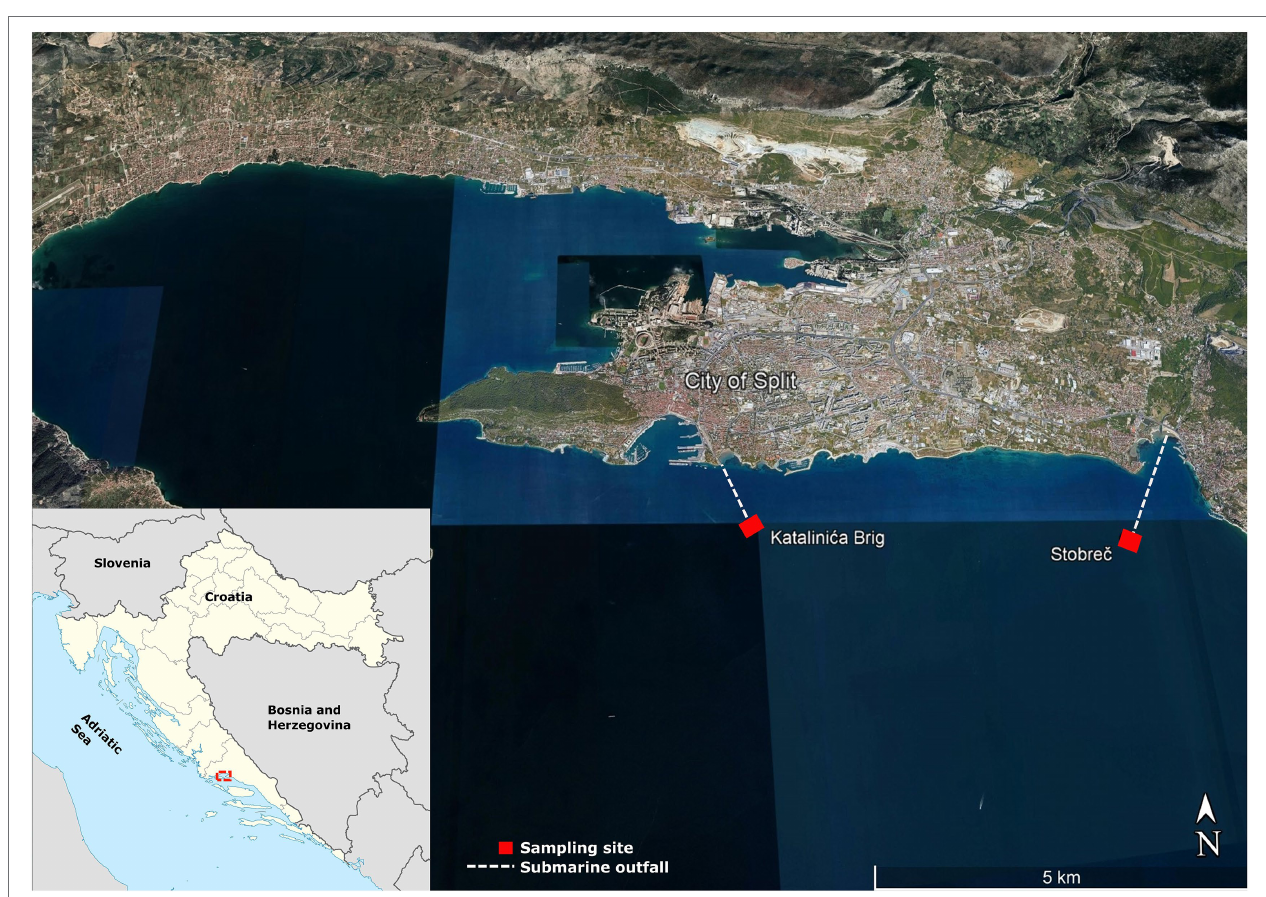
FIGURE 1 | Sampling sites (represented by squares) at the submarine outfalls of the two WWTPs, central Adriatic Sea,